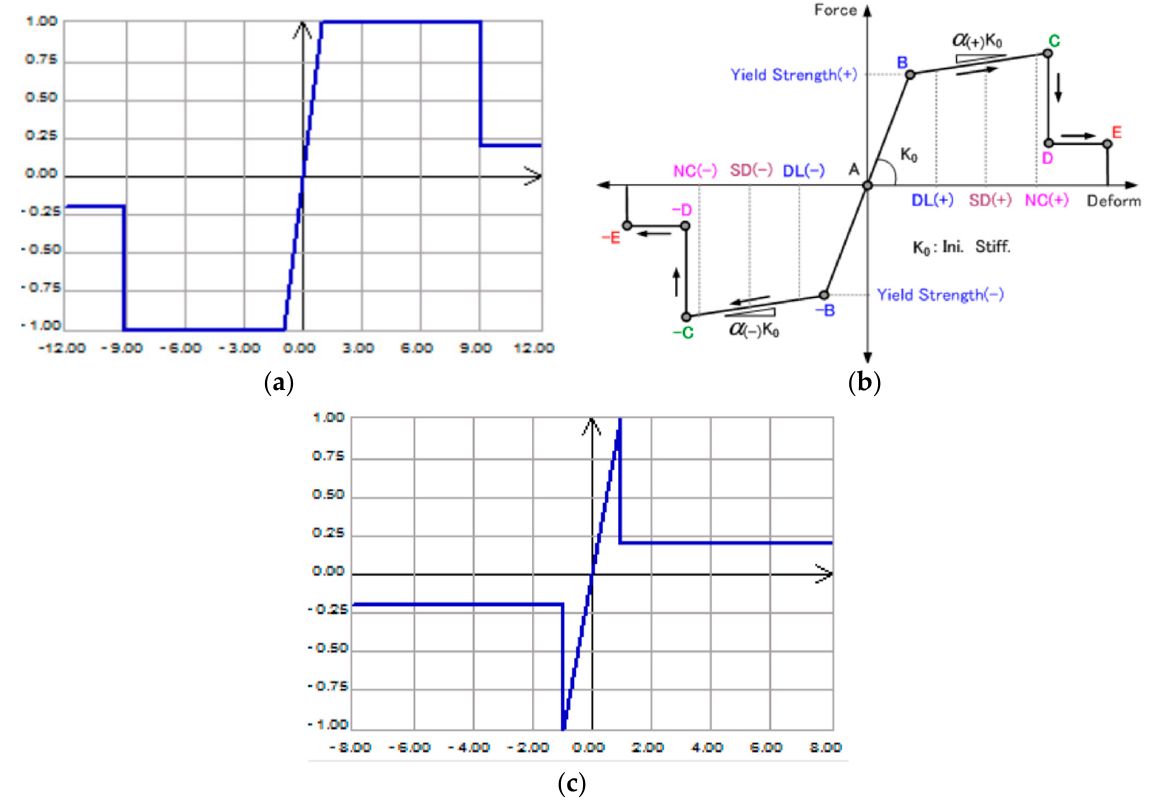
Figure 8. Lumped plasticity model approach: ( a ) moment-rotation constitutive law according to EC8; ( b ) quadrilinear moment-rotation constitutive law; ( c ) constitutive shear law.